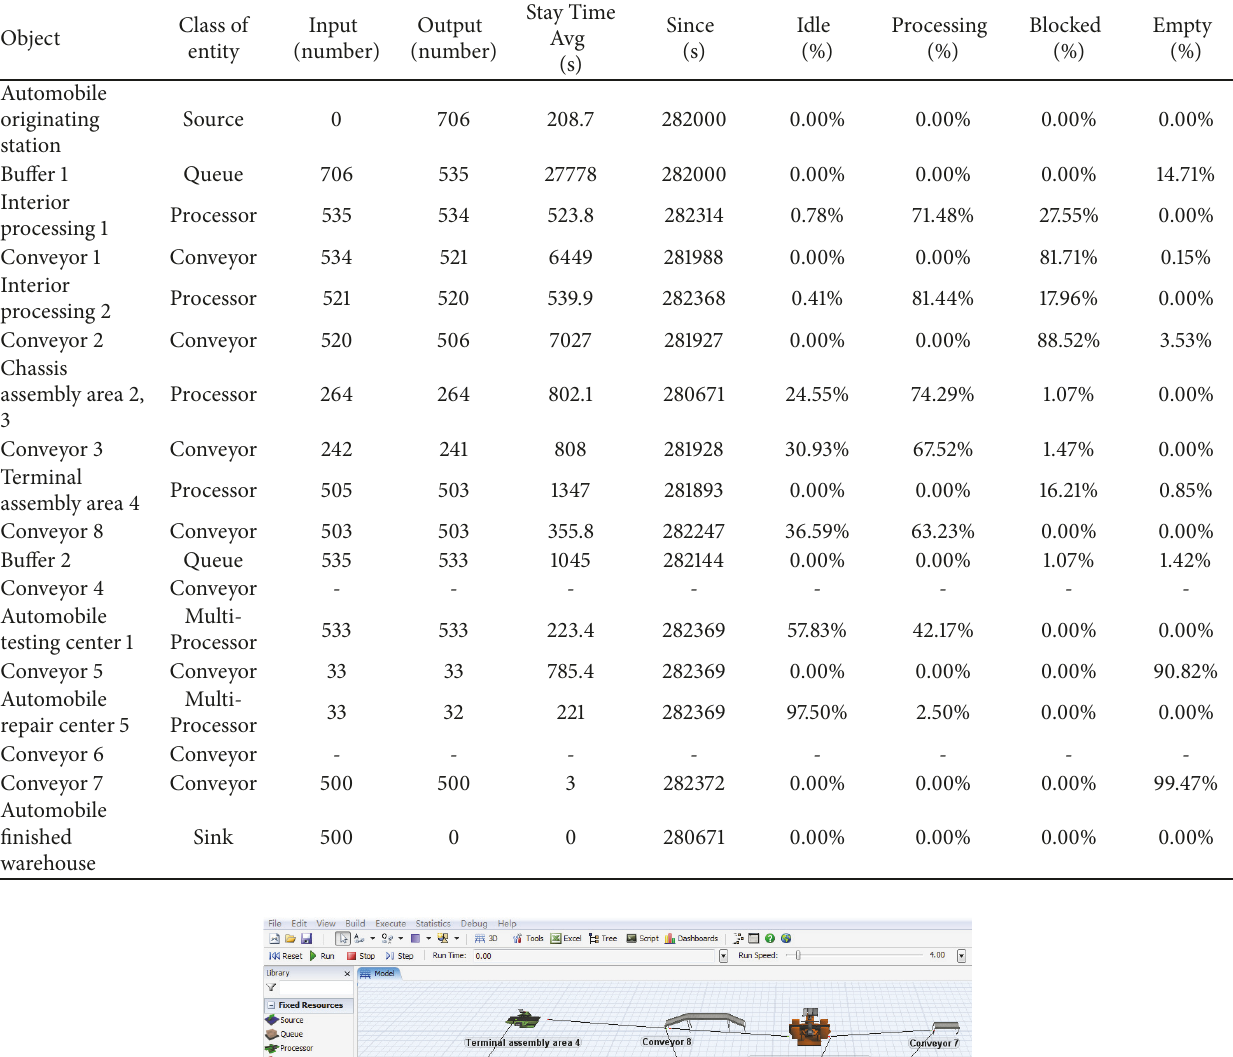
Table 4: Statistic data of mixed assembly process after optimization.